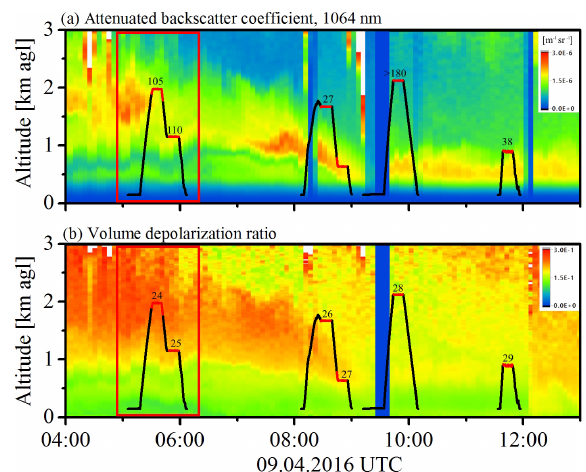
Figure 14. Time series of lidar observations measured in Nicosia on 9 April. The upper panel shows the attenuated backscatter sig- nal at 1064nm and the lower panel the volume depolarization ratio. The smoothed lidar image is superimposed on the UAS flight track (black). Periods of sampling are indicated in red (numbers 24 to 29 in panel b ). The numbers above the sampling period in panel a ) give the INP concentration in stdL − 1 at − 30 ◦ C and 135.4% ice saturation. Altitude is given in meters above ground level relative to the location of the lidar in Nicosia (180ma.s.l.). The red rectangle refers to the time periods investigated in Figs. 15, 16, and